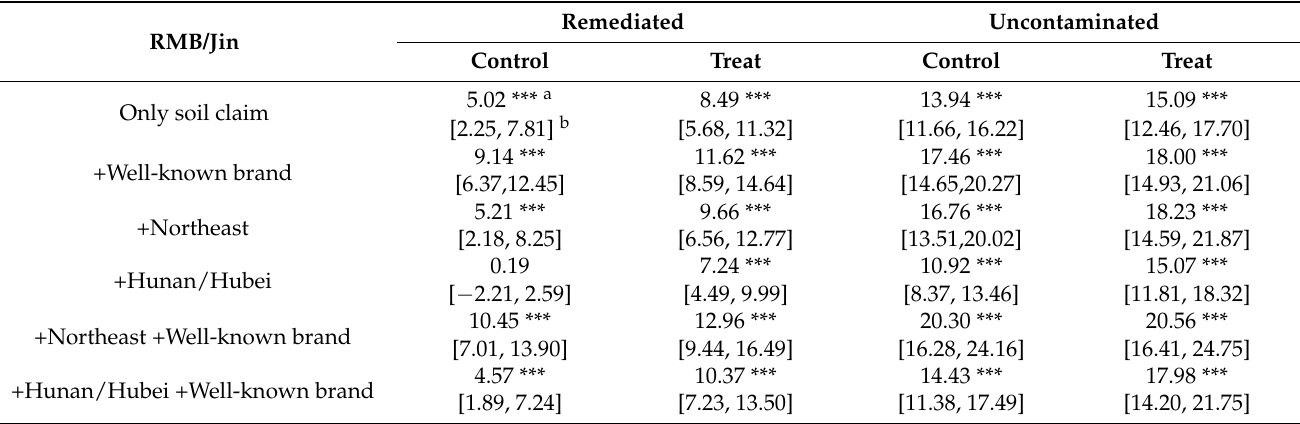
Table 6. WTP for soil claims with consideration of brand and region-of-origin attributes. Remediated Uncontaminated RMB/Jin Control Treat Control Treat Only soil